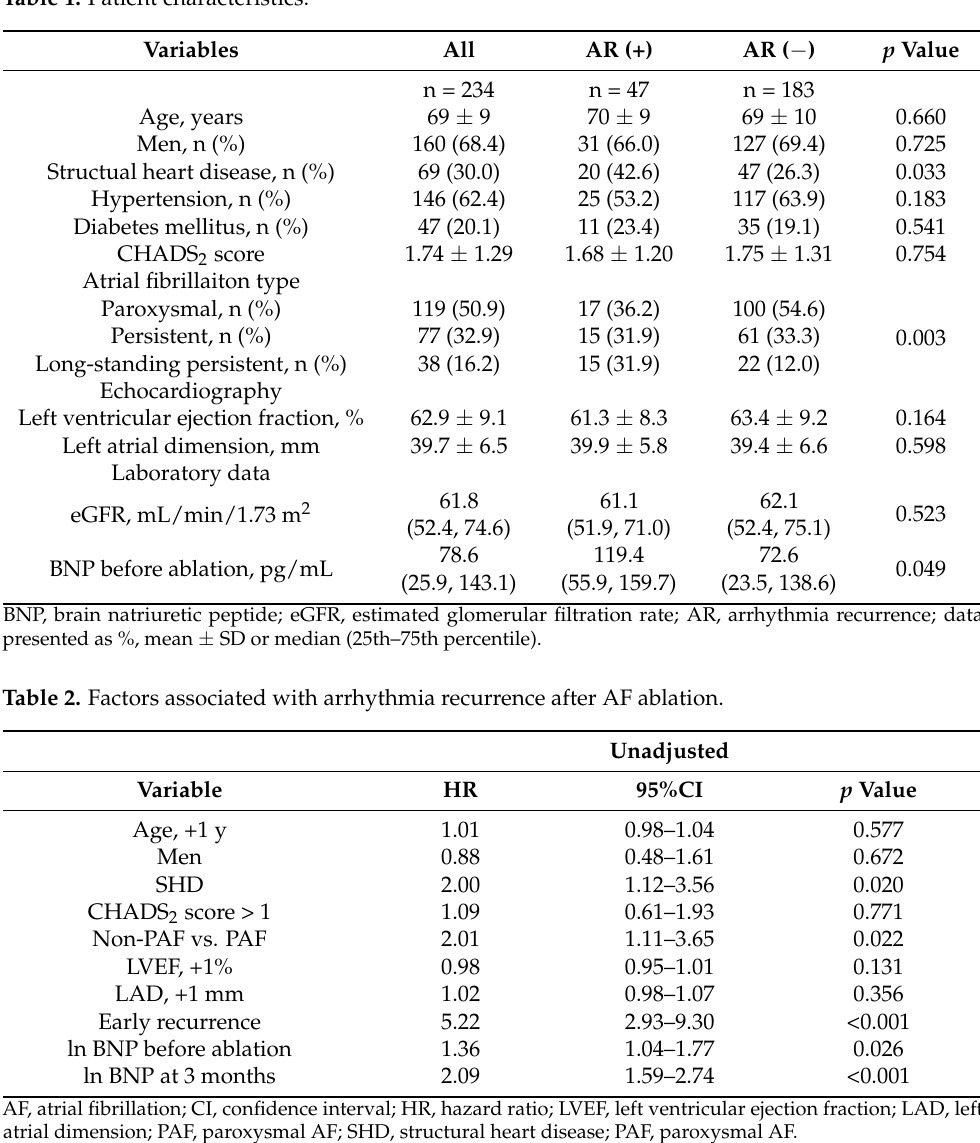
Table 1. Patient characteristics.